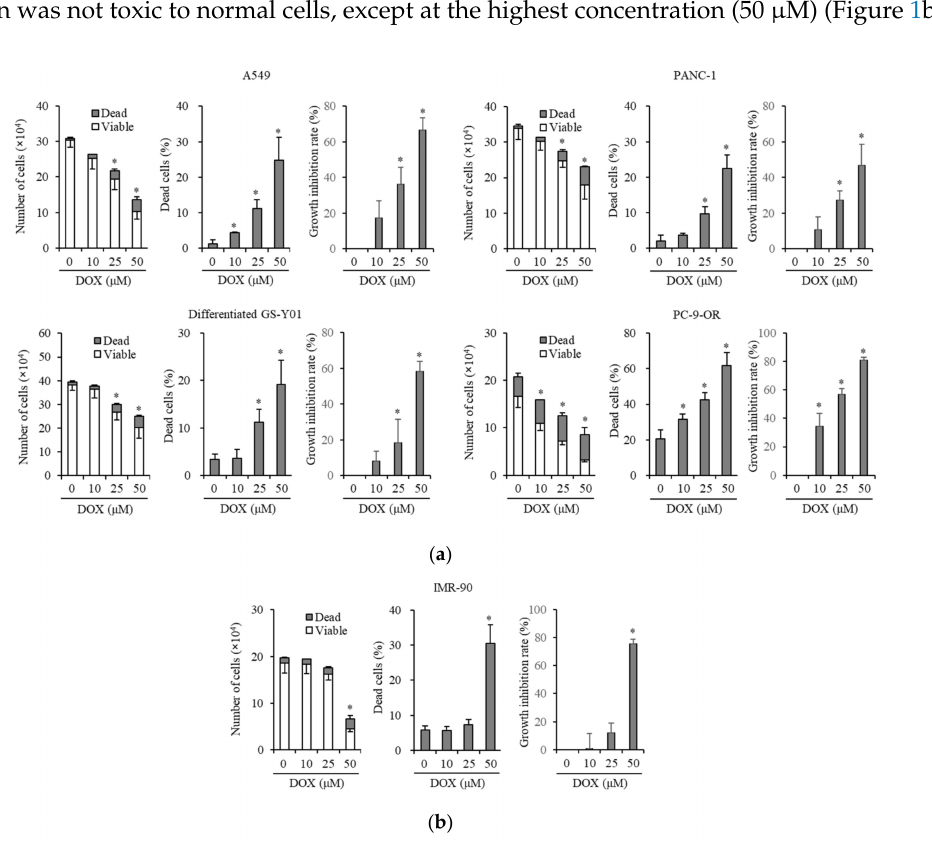
Figure 1. Doxazosin induces cancer cell death and inhibits cancer cell growth without a ff ecting non-tumor cells. A549, PANC-1, di ff erentiated GS-Y01 (di ff erentiated glioma stem cells induced by serum in culture medium), PC-9-OR (subline from PC-9, PC-9 osimertinib resistant) ( a ) and IMR-90 (normal human fibroblasts) cells ( b ) were treated with the indicated concentrations of doxazosin (DOX) for 3 days, and the numbers of viable and dead cells ( left panels ), the percentage of dead cells ( center panels ), and the growth inhibition rate ( right panels ) were assessed. Values in the graphs represent the means ± SD of triplicate samples of a representative experiment repeated with similar results. * p <